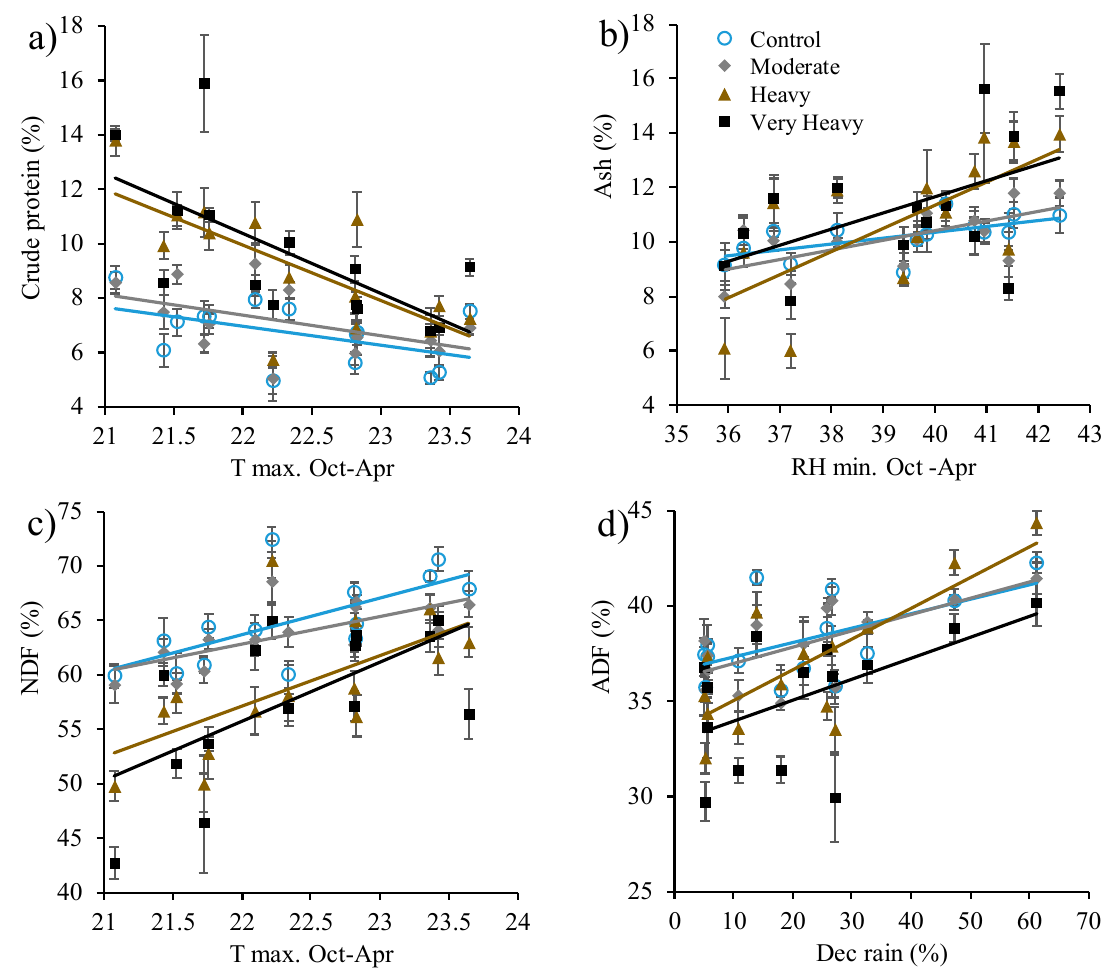
Figure 1. Relationships between the climate variables and mean nutritional parameters values under four grazing intensities. ( a ) Crude protein content in herbage (%) and winter daily maximum temperature, ( b ) herbage ash content (%) and winter daily minimum relative humidity, ( c ) herbage NDF (neutral detergent fiber) content (%) and winter daily maximum temperature, and ( d ) herbage ADF (acid detergent fiber) content (%) and the proportion of annual rain in December. The climate variables presented in the graphs provided the most parsimonious model among the nine different climate variables tested. Data were collected annually at the Karei Deshe Experimental Station. Each point represents the average of six pooled samples (of n = 6–8 samples each). The solid trend lines are significant at p ≤